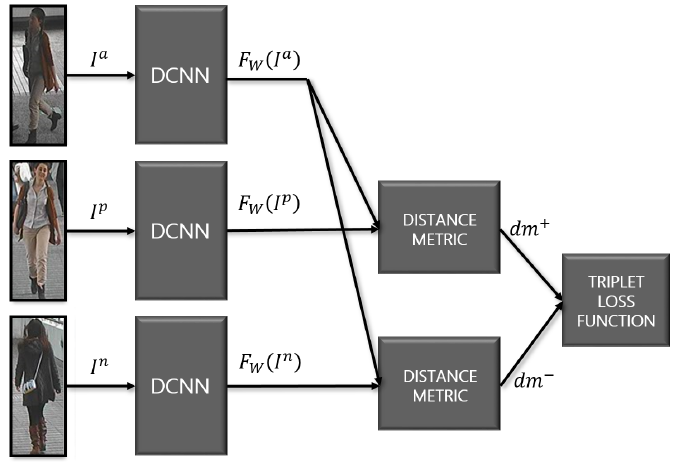
Figure 8. Architecture of the Triplet